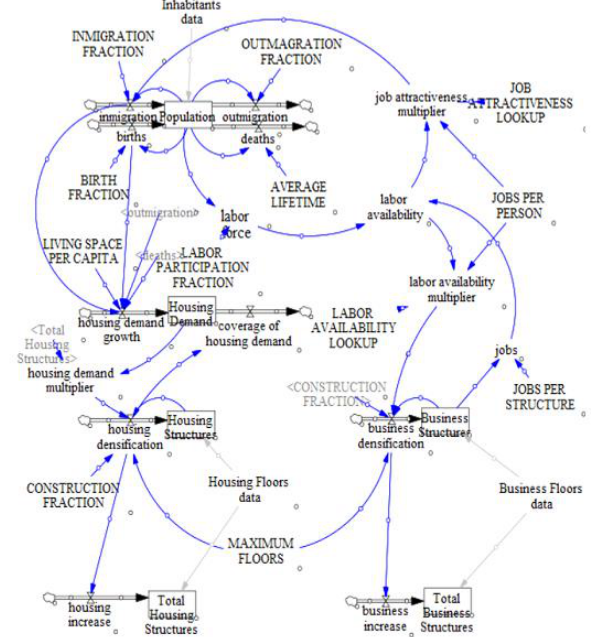
Figure 3: Spatial system dynamics model simulating urban